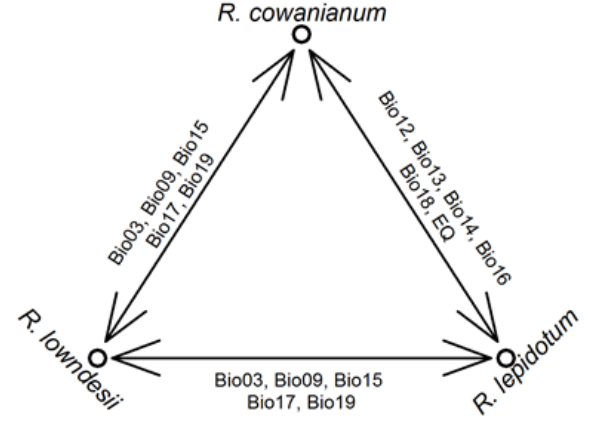
Figure 2. Climate variables that were significantly differ- ent between the realized distributions of the three spe- cies. Variable acronyms correspond to isothermality (bio03), mean temperature of the driest quarter (bio09), annual precipitation (bio12), precipitation of the wettest month (bio13), precipitation of the driest month (bio14), precipitation seasonality (coefficient of variation) (bio15), precipitation of the wettest quarter (bio16), precipitation of the driest quarter (bio17), precipitation of the warm- est quarter (bio18), precipitation of the coldest quarter (bio19) and Ellenberg Climatic Quotient (EQ).